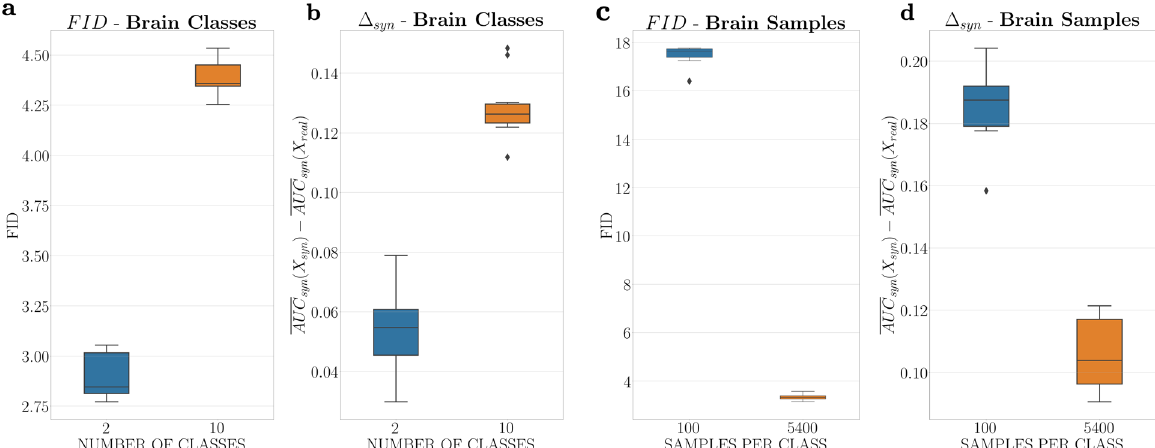
Fig. 3 Label over fi tting analysis of the cpD-GAN on brain CT scans for the extrema settings from our benchmark. Box plots showing the median, the interquartile range (IQR = Q3 − Q1), the minimum (Q1 − 1.5 IQR), the maximum (Q3 + 1.5 IQR) and outliers for: a FID scores between 10,000 real and synthetic images after GAN convergence for 2 and 10 classes; b Δ syn scores, the difference between testing the predictive model on synthetic and real images after training on synthetics for 2 and 10 classes; c FID scores between 10,000 real and synthetic images after GAN convergence for 100 and 5400 samples per class; d Δ syn scores, the difference between testing the predictive model on synthetic and real images after training on synthetics for 100 and 5400 samples per class. Please see Table 1 for more details on the dataset composition for the extrema settings from our